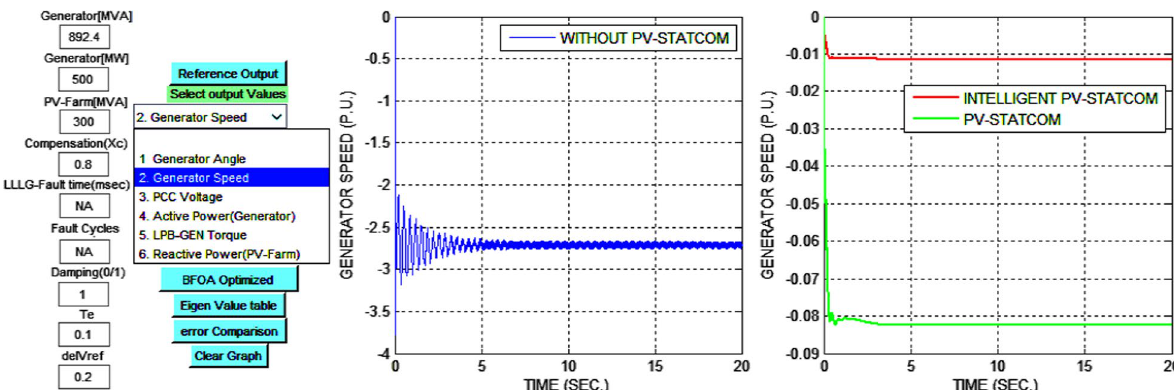
Table 2. The eigenvalue and damping ratio for the 5th